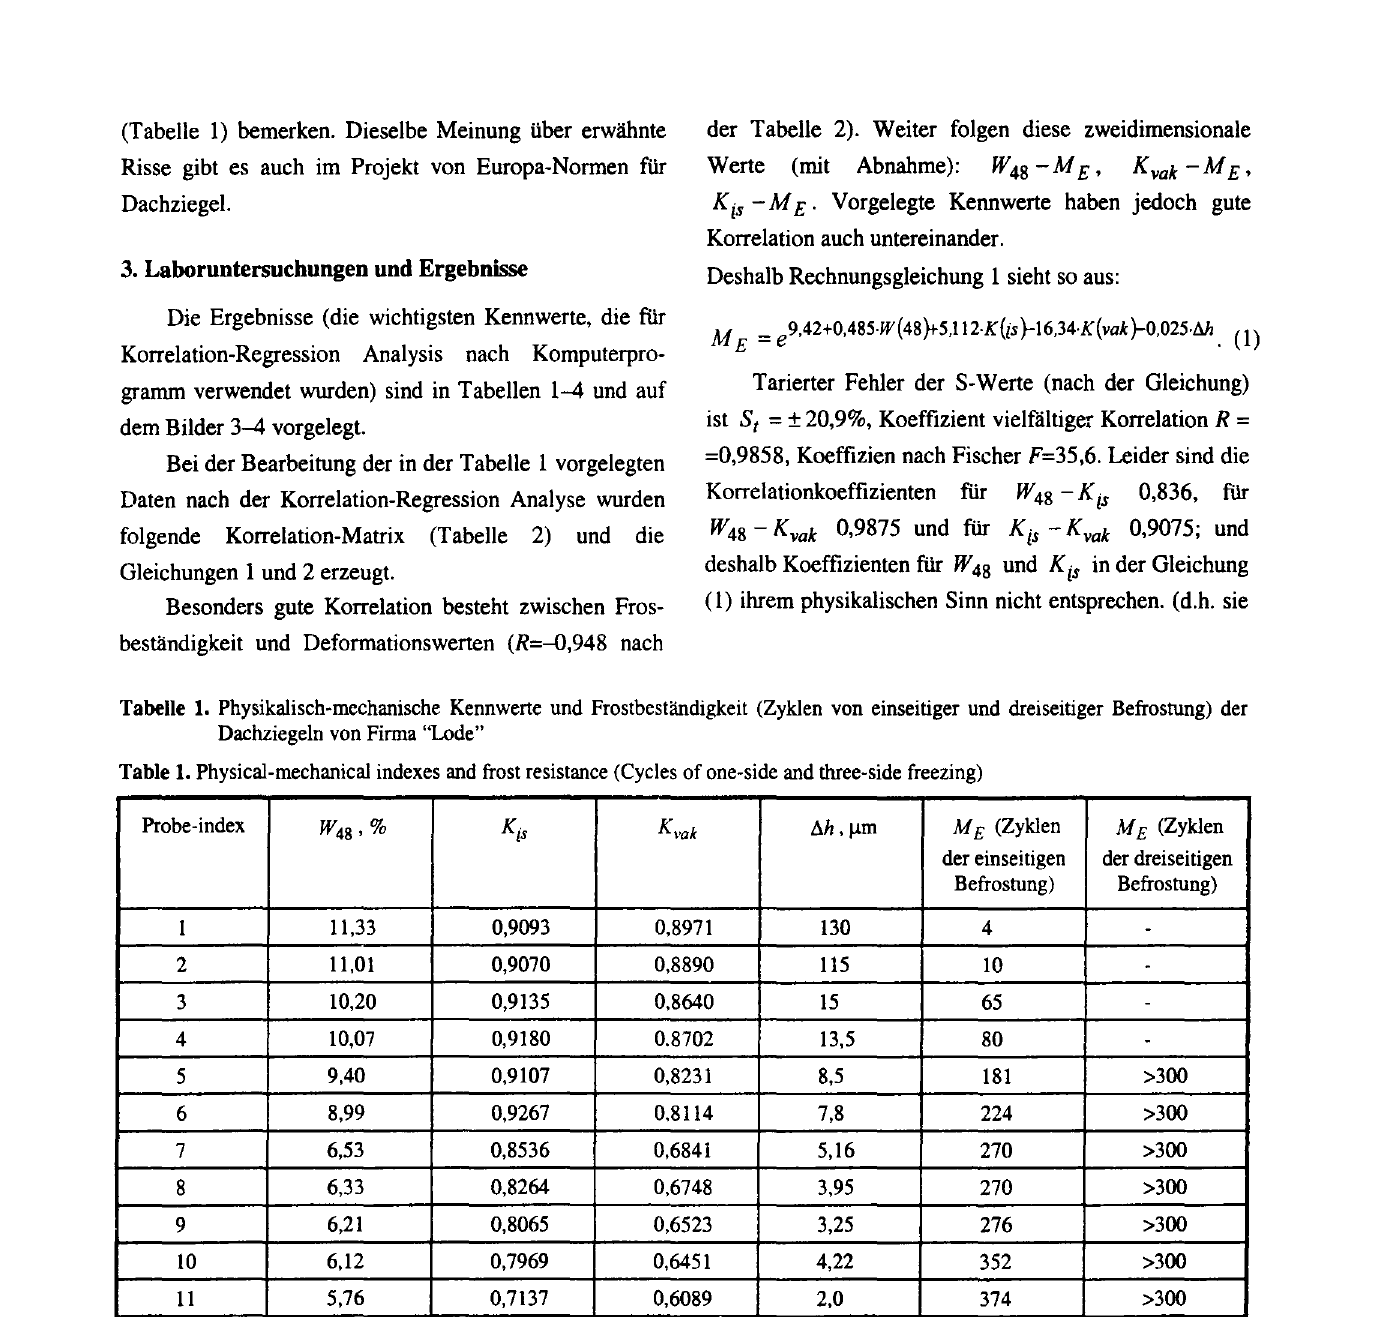
Table 2. Correlation matrix of W 48 - Kis - Kvak - L\h-